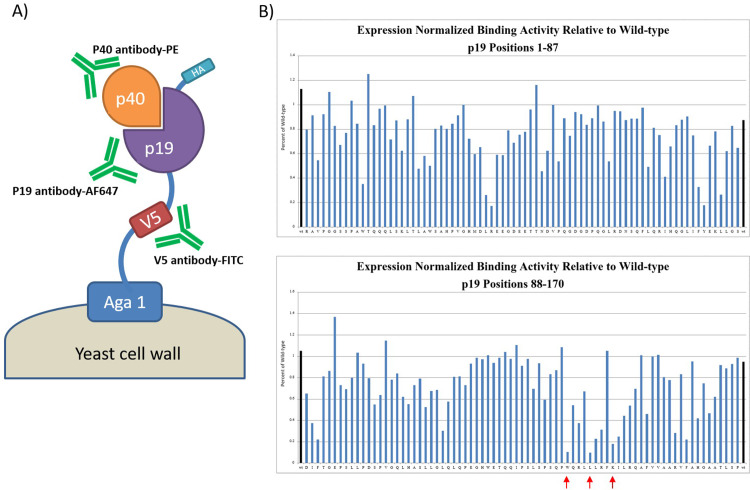
Display of IL-23 and p19 alanine variants on yeast.A) P19 subunit was anchored on yeast surface by fusion to vial V5-tag. P40 was expressed as soluble protein. Antibodies against p19, p40, and V5-tag were used to isolate yeast cells with correct assembly of IL-23 heteromer. B) Normalized binding of IL-23R to wild-type IL-23 and alanine variants of p19 displayed on yeast (n = 1). Binding of wild-type IL-23 is shown in black bar and binding of W137A, L141A, and K145A are indicated by red arrows.